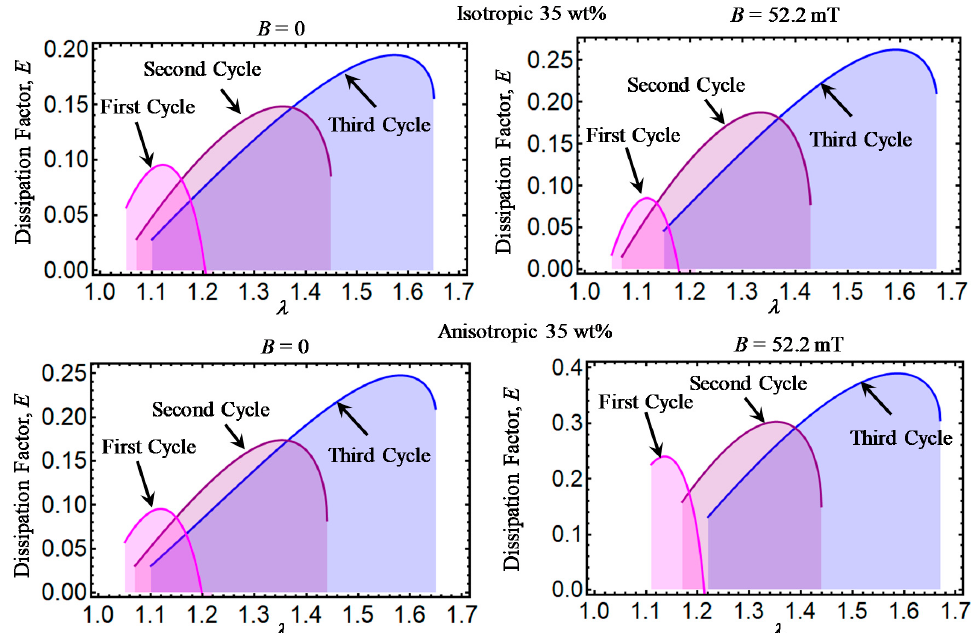
Figure 7. Dissipation factor curves for magnetorheological material samples made with a concentration of 35 wt% of CIPs.